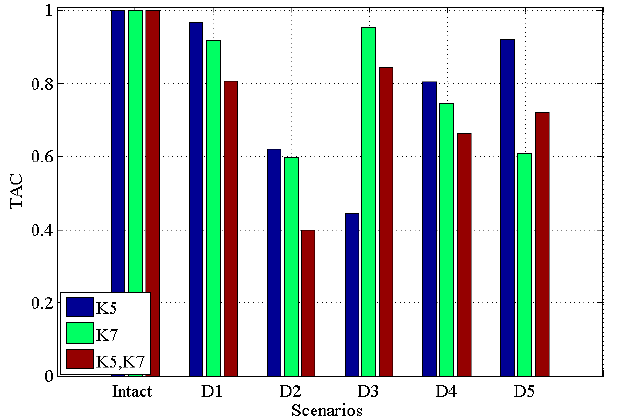
Figure 5. CDI for five damaged scenarios with intact scenario with 2% noise for single damage in K5, single damage in K7, multiple damages in K5 and K7, respectively.